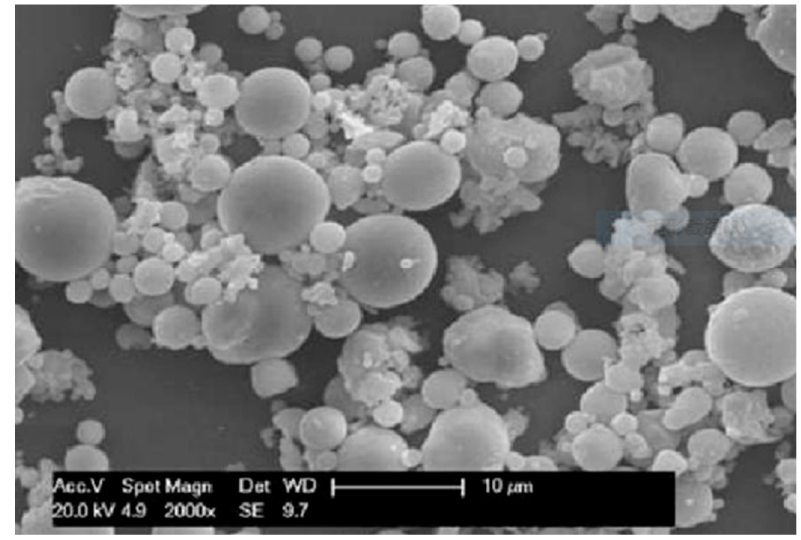
Figure 4. SEM image of fly ash.